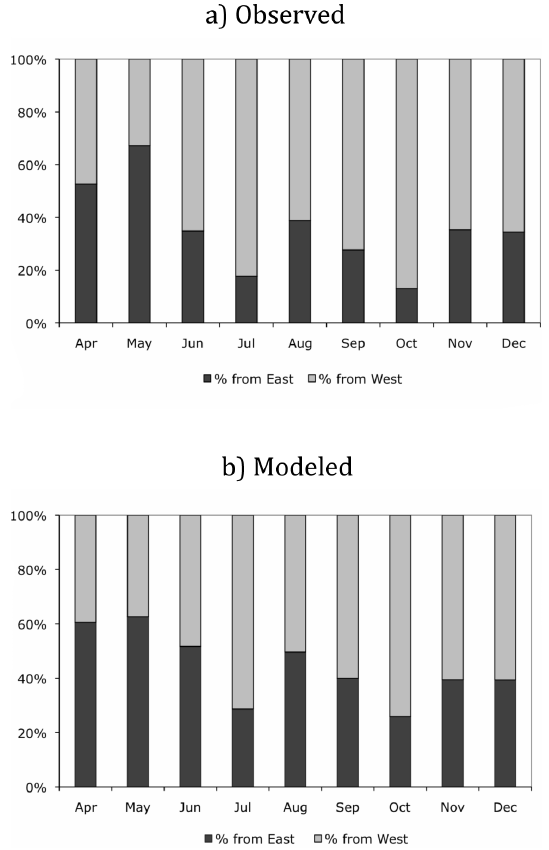
Fig. 4. 2003 wind direction at DL from (a) measurements (Rutter et al., 2008a); (b) CMAQ-Hg (10-m wind-speed generated by the WRF model and processed with MCIP v. 3.4). Wind direction was aggregated such that all directions between 0° and 179° were con- sidered from the east and all wind directions greater than or equal to 180° were labeled as from the